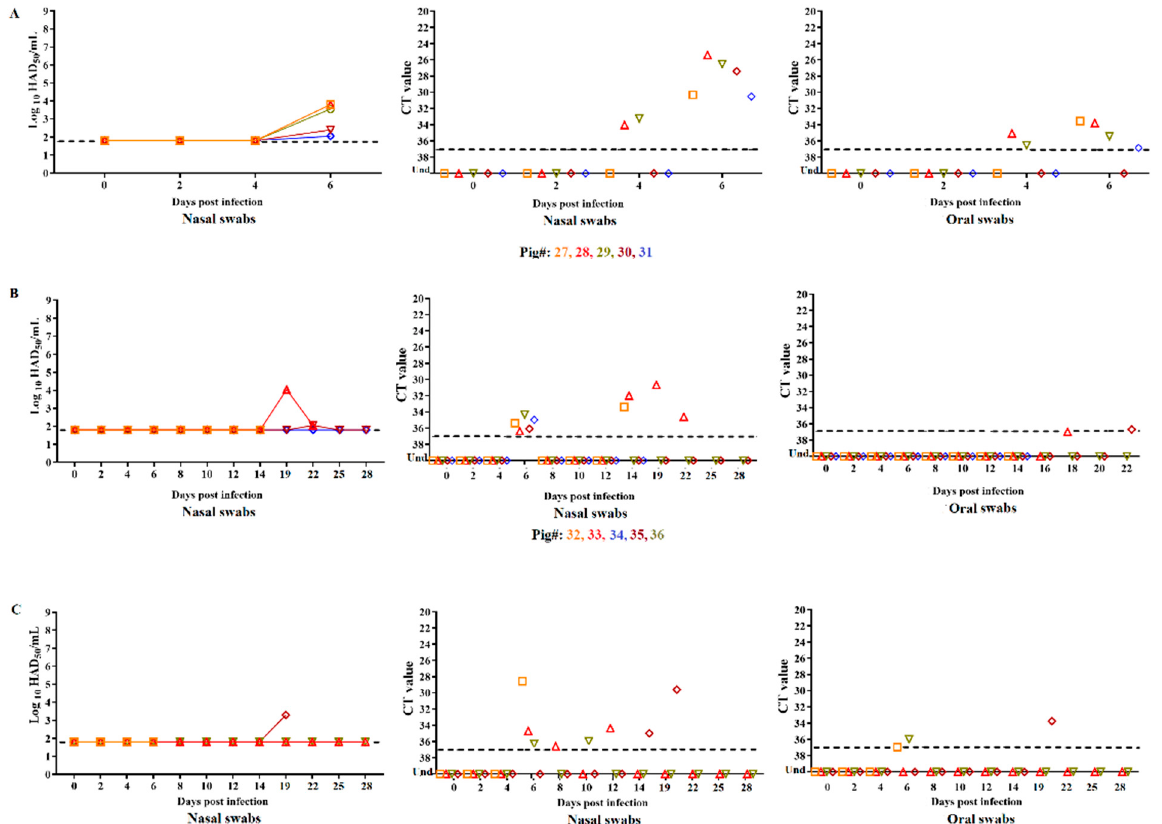
Figure 4. Presence of virus in nasal (detected by titration of infectious virus and qPCR) and oral swabs (detected by qPCR) collected from animals inoculated with ASFV-DR21 IM ( A ), by contact ( B ), or ON ( C ) from day 1–28 pi. Data are presented as individual values of virus titers (expressed as HAD 50 /mL), and qPCR CT values with different colored lines and symbols representing individual animals. Sensitivity of detection of infectious virus is ≥ 1.8 log 10 /mL and considered positive by qPCR with CT values ≤ 37. Animal #45 was excluded from the data presented due to removal from the study on day 0.